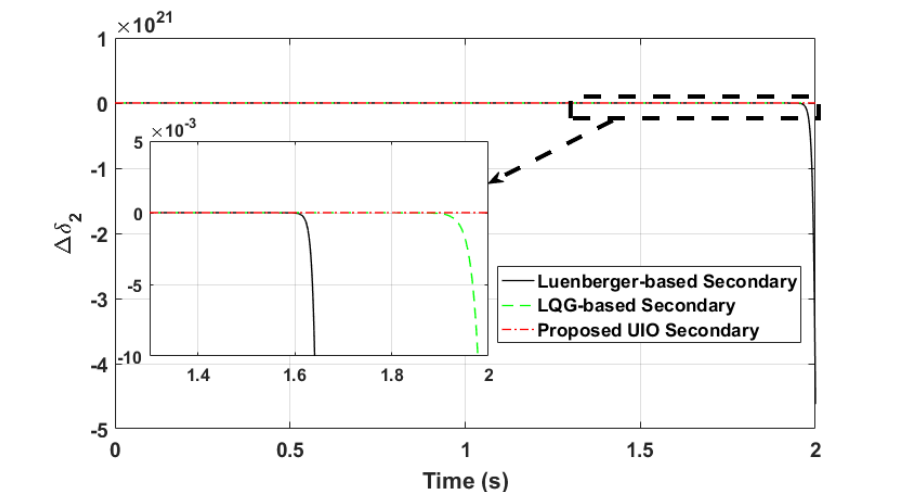
Figure 14. Second inverter angle δ 2 in scenario 3 (Stealthy FDI to second inverter’s